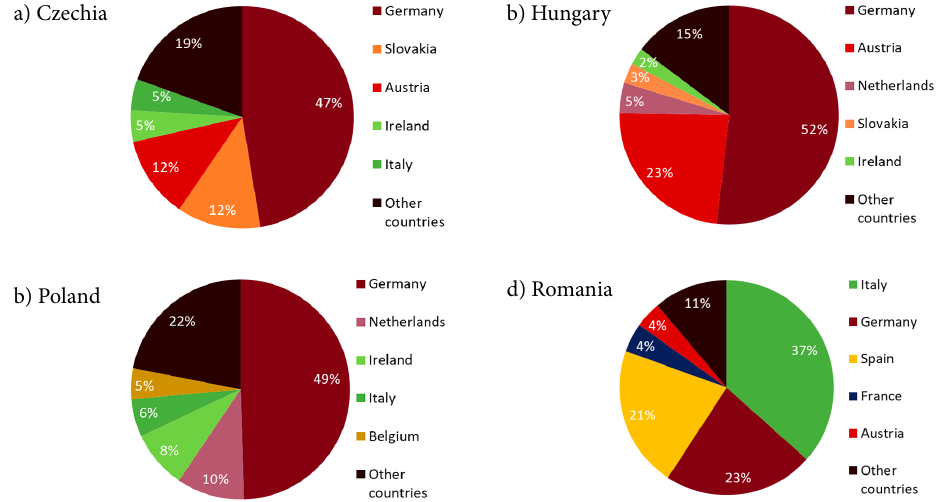
Figure A.4. Citizens in EU countries (source: Eurostat, authors’